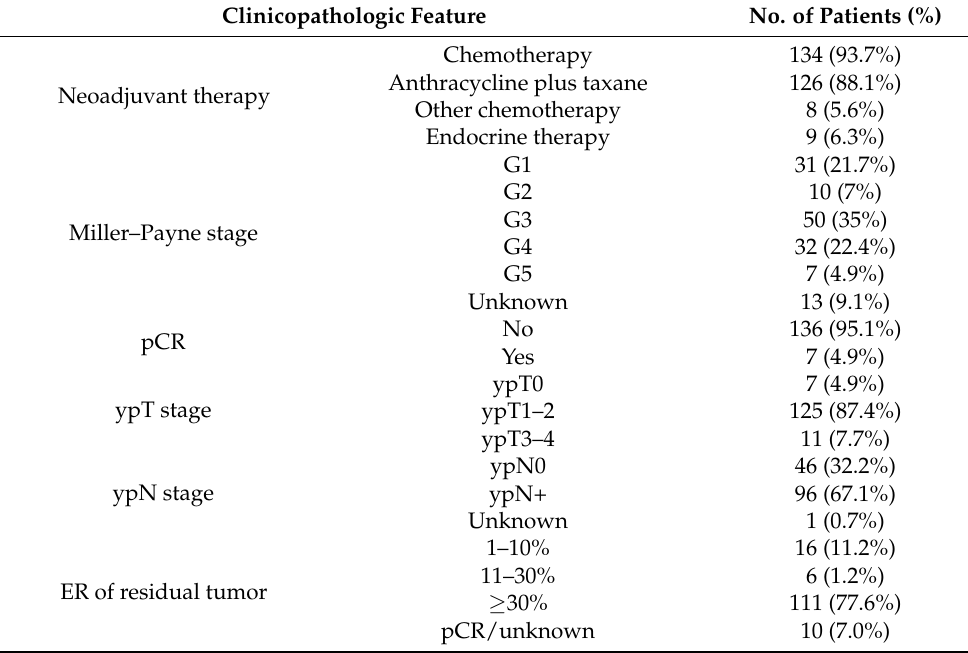
Table 2. Characteristic of neoadjuvant